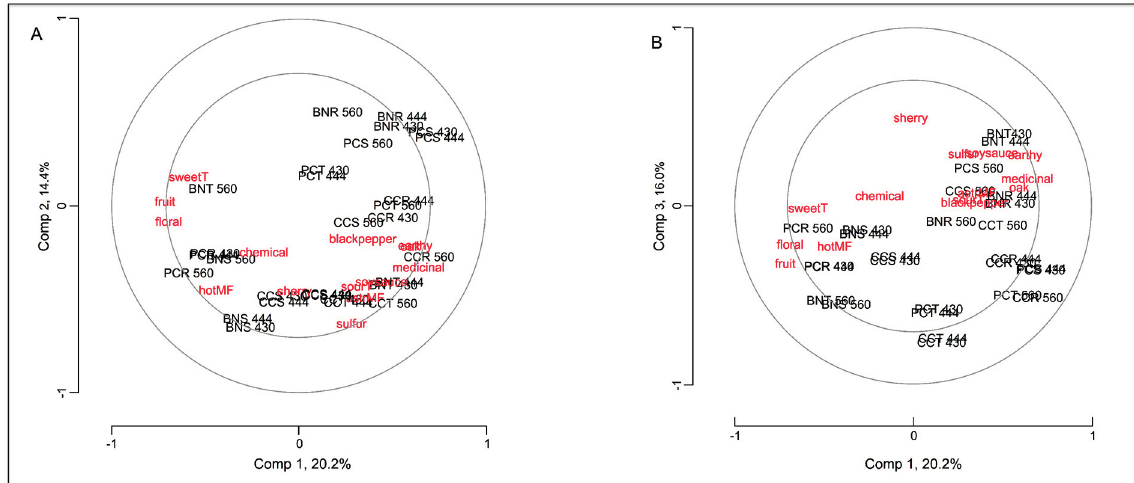
Figure 4. PLSR correlation plot of the predicting variables in black (responses of the peptide assay) and the predicted variables in red (wine sensory attributes) on the first three dimensions; component 1 vs. component 2 ( A ) and component 1 vs. component 3 ( B ). As shown, the peptide sensors are mostly correlate to taste and mouth feel sensory attributes of red wine and, more specifically, to perceived astringency (astrMF).